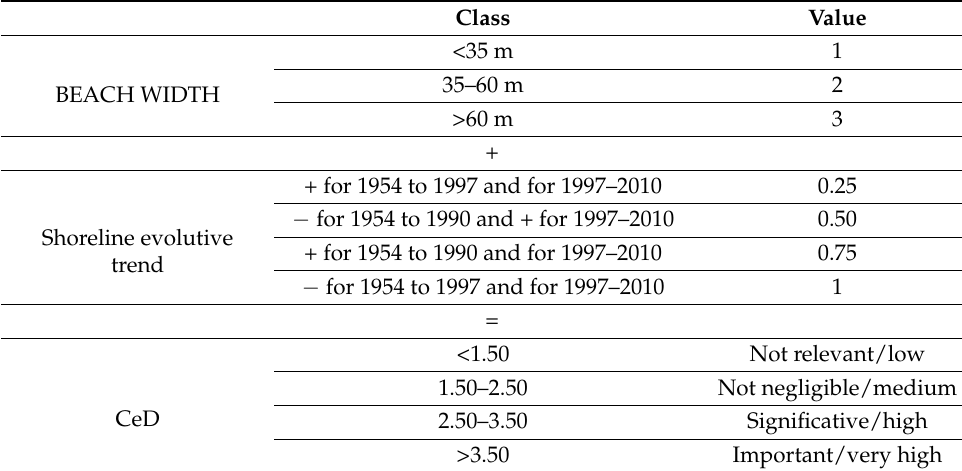
Table 6. Parameters used for the CeD approach.